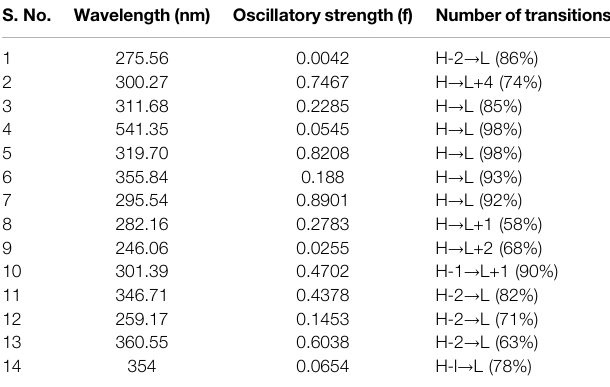
TABLE 4 | CLP: clog P, TPSA: topological polar surface area, Natoms: number of atoms, MW: molecular weight, S: solubility, HBA: number of hydrogen bond acceptor,andHBD:numberofhydrogen